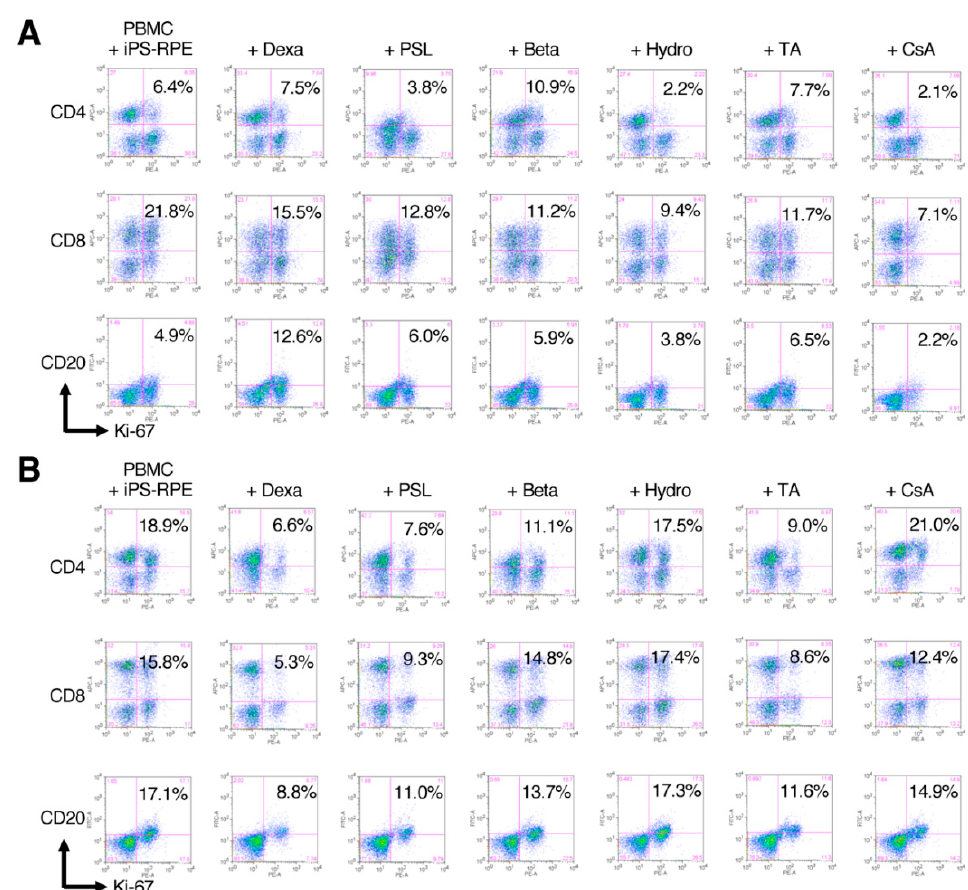
Figure 3. Representative FACS results of Drug-LGIR in PBMC from healthy or transplanted monkeys. In the Drug-LGIR assay, PBMCs were cultured with human iPSC-RPE cells in the presence of indicated drugs for 5 days, and the suppressive effects of the drugs were evaluated by FACS of Ki-67 expressing cells. ( A ) The results of monkey HM-5 before transplantation. Hydrocortisone, prednisolone, and cyclosporine A exhibited significant suppression of the proliferation of the immune cell. By contrast, dexamethasone, betamethasone, and triamcinolone were not suppressive. ( B ) The results of monkey HM-2 that showed immune rejection against human iPSC-RPE cells in vivo. In the results of the in vitro assay, dexamethasone exhibited significant suppression of the immune reaction. Prednisolone and triamcinolone also exhibited suppressive effects. However, other drugs were not suppressive.